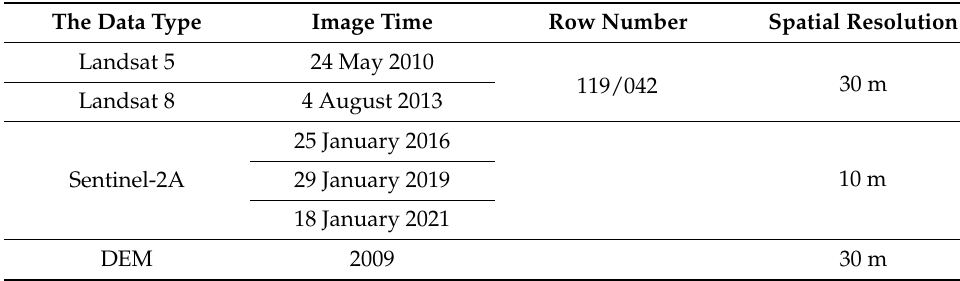
Figure 1. Location of the study area. Table 1. Data source